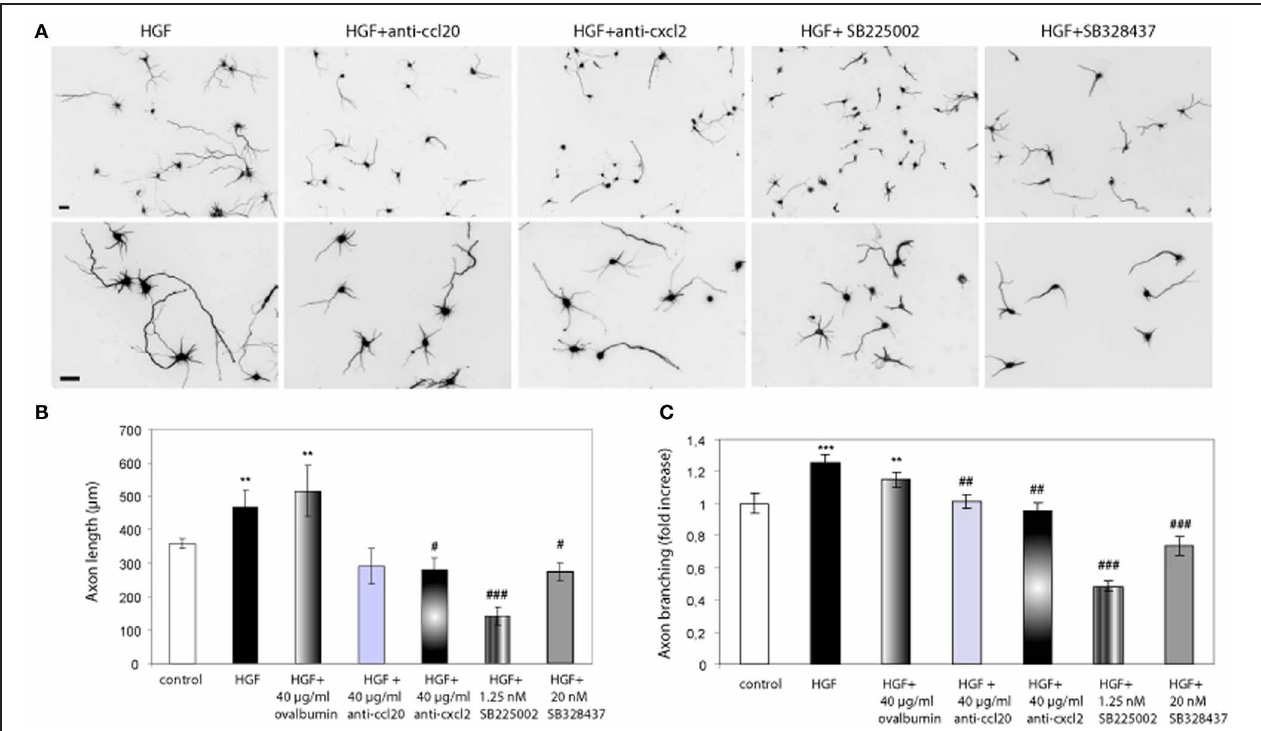
FIGURE 3 | Chemokine signaling is involved in the axon morphogenesis promoted by HGF. (A) Hippocampal neurons treated with HGF (50ng/ml) together with anti-CCL20 (40ug/ml), anti-CXCL2 (40 μ g/ml), SB225502 (1.25nM) or SB324837 (20nM), and immunostained for β III-tubulin. Top pictures were taken at 10 × and bottom at 20 × . Bars = 30 μ m. (B and C)